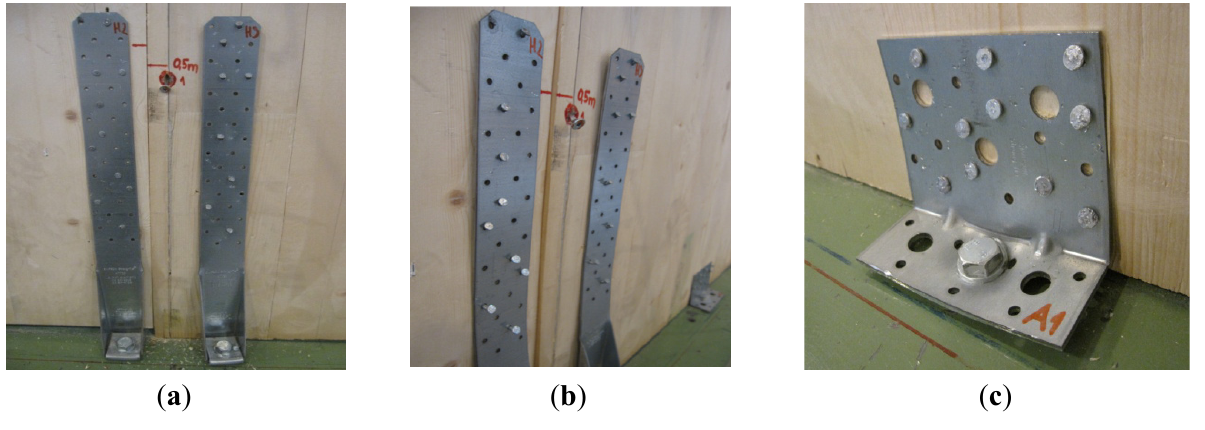
Figure 10. Wall A: Details of connection system at end of testing: ( a ) uplift of hold-down; ( b ) nail and screw deformation; ( c ) deformation of shear